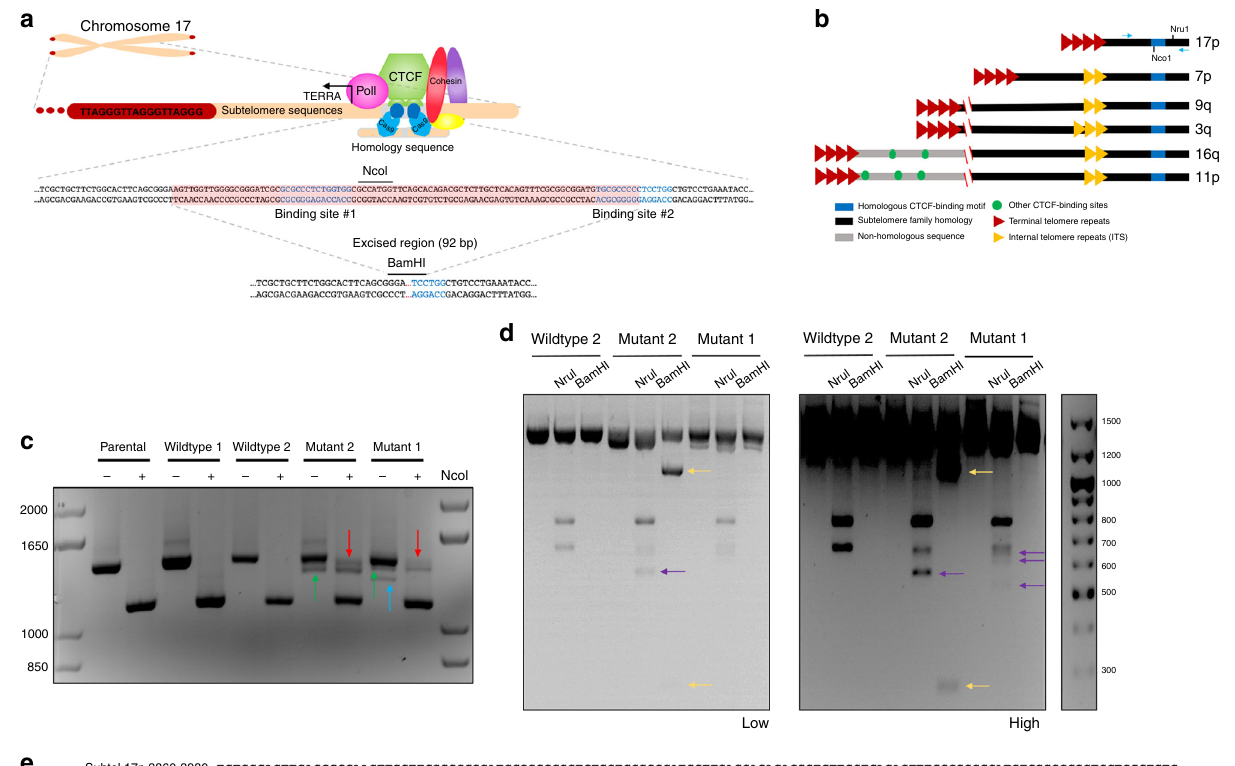
Fig. 1 CRISPR-engineered mutants of CTCF 17p family subtelomere-binding sites. a CRISPR – Cas9 guide RNAs were designed to target regions around the CTCF-binding motif on the subtelomere of 17p. Homology-directed repair was promoted by co-transfection of a DNA fragment-containing homologous DNA sequences fl anking a BamH1 site, created by deleting 92 bp base pairs of DNA surrounding the CTCF-binding motif. b Schematic depicting basic homology between 17p family of subtelomeres. c A 1400 bp fragment of DNA surrounding the deleted locus was PCR-ampli fi ed from genomic DNA collected from CRISPR clonal cell lines. PCR fragments from parental, or selected wildtype and mutant cells were undigested ( − ) or digested (+) with NcoI, a restriction site only present within the 92 bp deleted region. Undigested mutant fragments are indicated with red arrows. Green and blue arrows indicate mutant fragments of decreased size in undigested samples. DNA markers in fi rst and last lanes. d Further digests with NruI and BamHI were utilized to identify mutant fragments. NruI digests outside the excised region only on 17p and 11p and generates two bands, 640/760 bp in wildtype and 548/760 bp in mutants. Purple arrows indicate bands created by mutant fragments. The BamHI cut site is introduced in clones that are repaired by perfect homologous recombination using the supplied gene block. Digestions creates 2 bands from mutant fragments, at 246 bp and 1063 bp, indicated by yellow arrows. Low (left) or high (right) image exposure. e Sanger DNA sequence validation of PCR fragment from Mutant 2 compared to wildtype clone and 17p